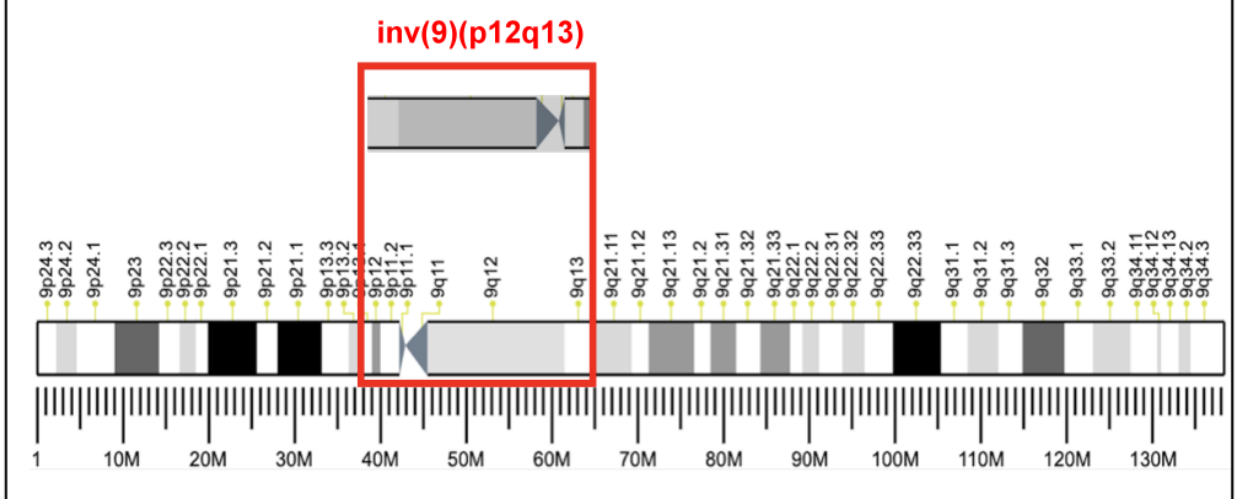
Figure 1. Cytogenetic map of the pericentric inversion of chromosome 9 (p12q13) in the infertile male partner.